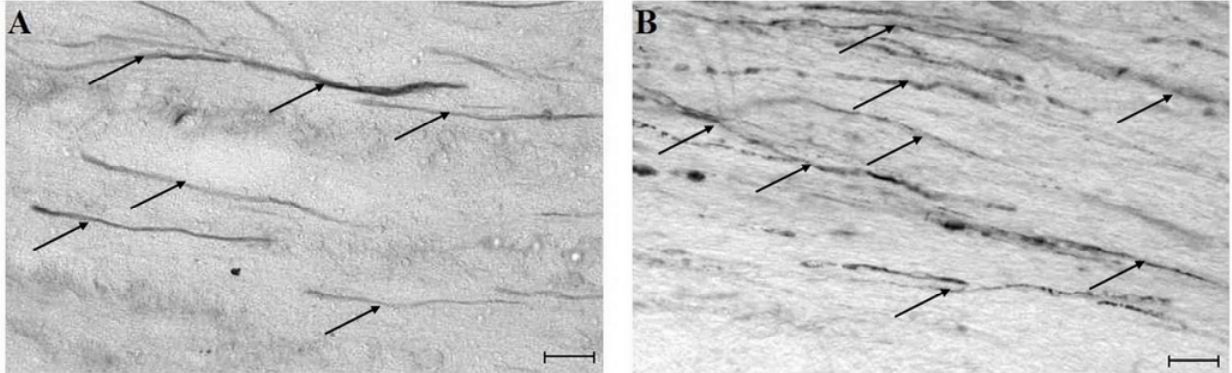
(A–B) from injured animals. Arrows show HRP-labeled axonal profiles. Note that the length of damaged axons appears reduced in the MDL-28170-treated (A) compared to the vehicle-treated (B) section in the CSpT and vehicle treated axons display a more vacuolized appearance. (Magnification bar indicates 20 μ